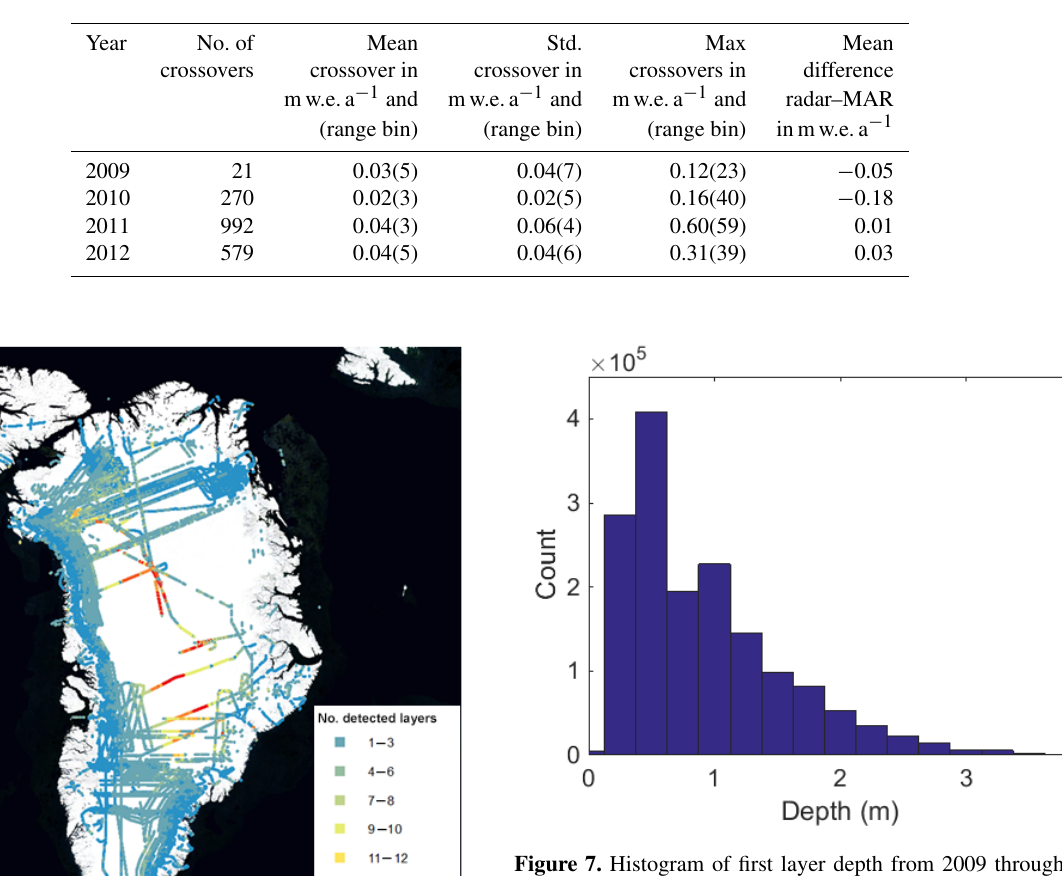
Table 1. Radar-derived accumulation-rate crossover analysis. Columns include the year the radar data were collected and the number, the mean, the standard deviation and the maximum difference of radar-derived accumulation at crossover points. Minimum crossover values were 0 for all years. The final column shows the mean difference between the gridded radar-derived accumulation and the MAR estimates of accumulation from 1 July to 30 April.